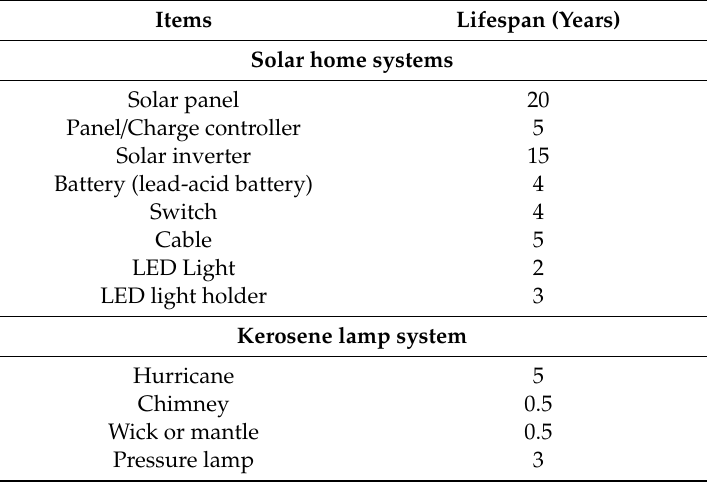
Table 2. Required assumptions for this